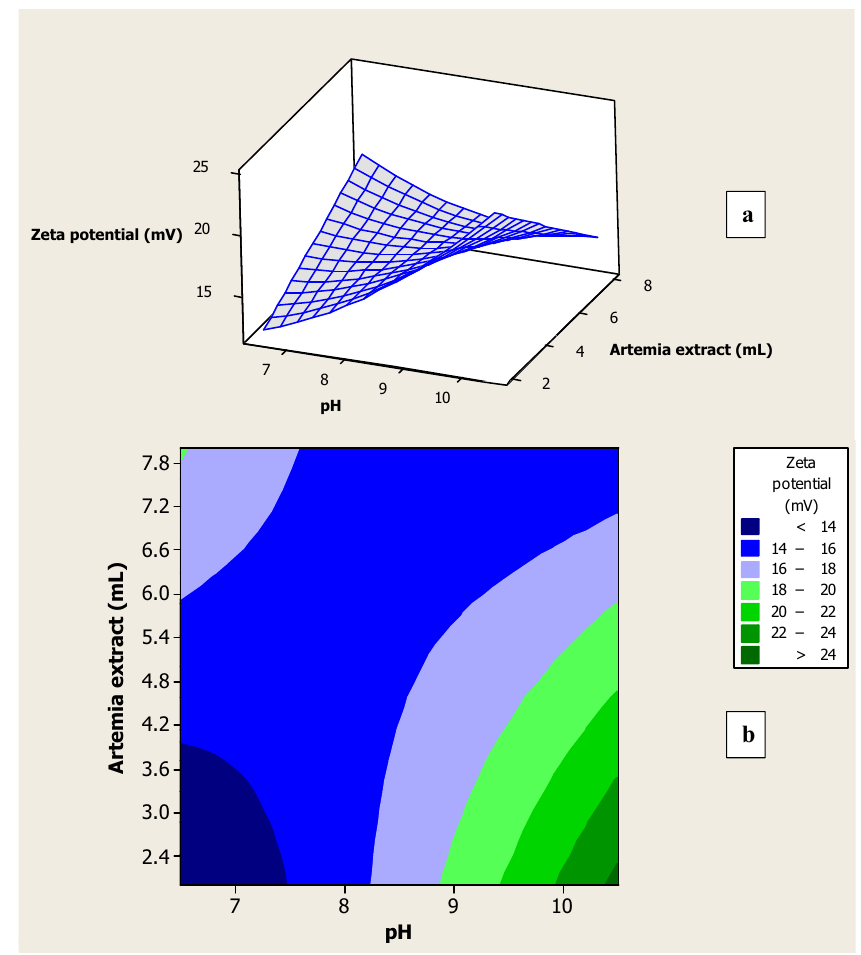
Figure 4: Surface plot ( a ) and contour plot ( b ) for zeta potential of the fabricated Au NPs as a function of amount and pH of the prepared A. urumiana